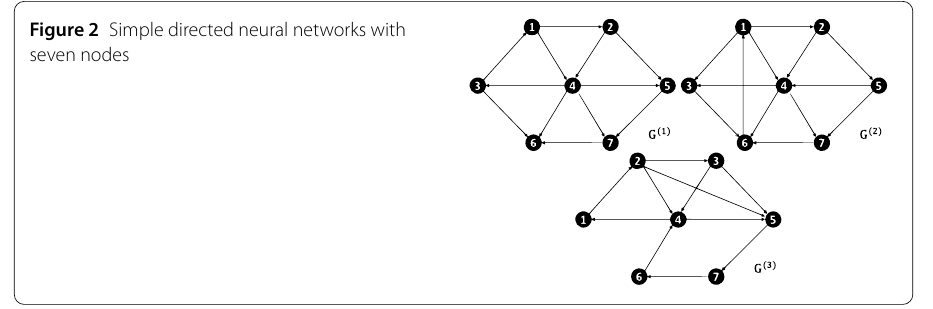
Figure 2 Simple directed neural networks with seven nodes